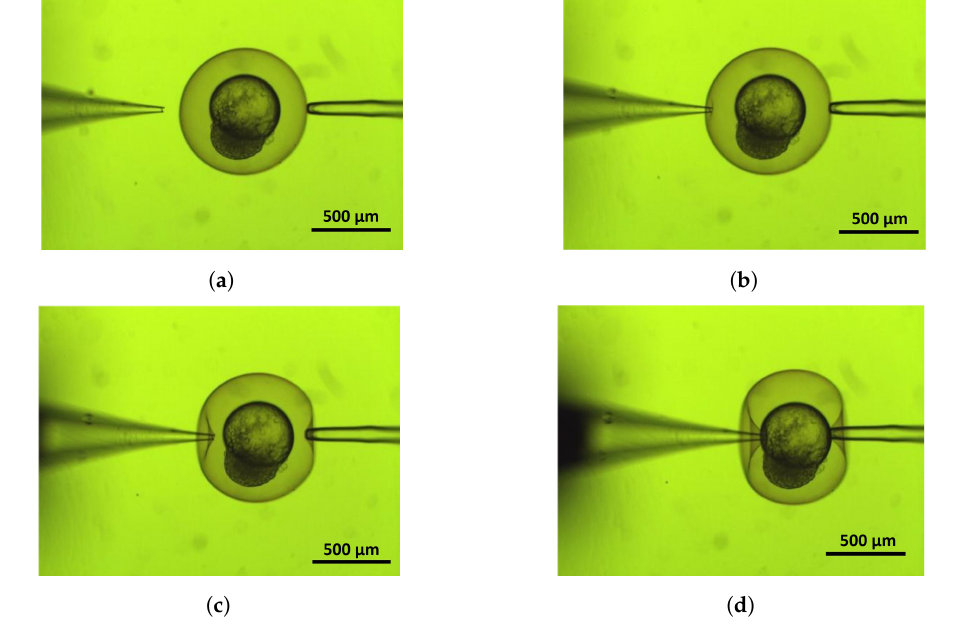
Figure 3. Cell deformation for different stages of zebrafish injection: ( a ) positioning, ( b , c ) deforming, ( d )